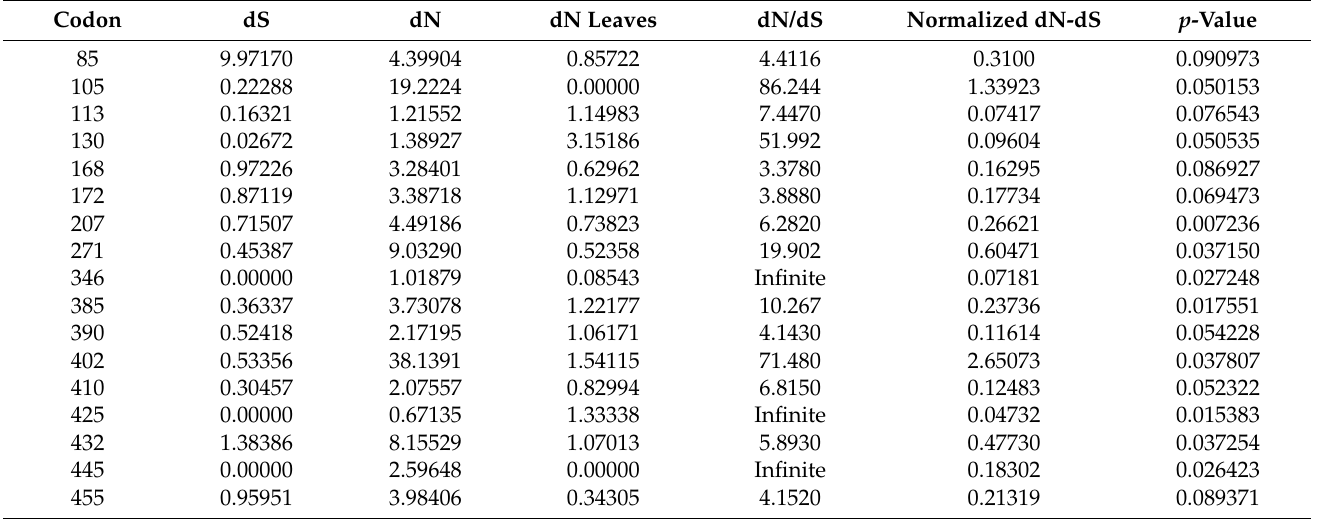
Table 5. Positive selection sites using